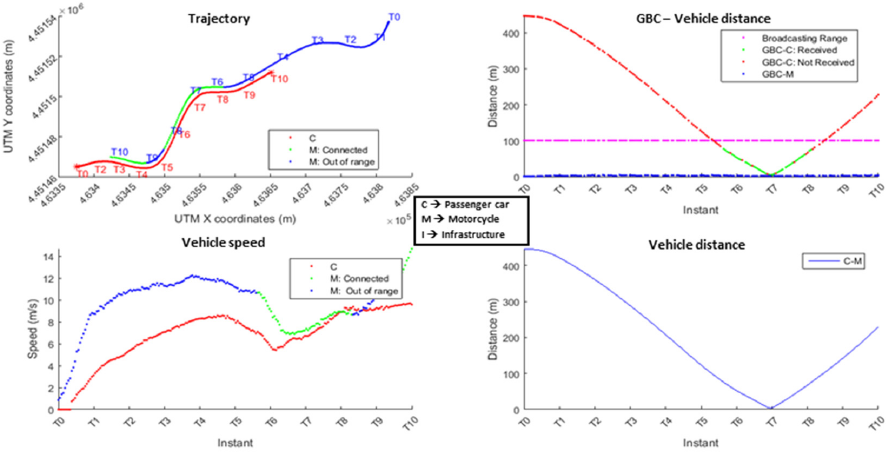
Figure 5. Results of Test 1 without RSU.